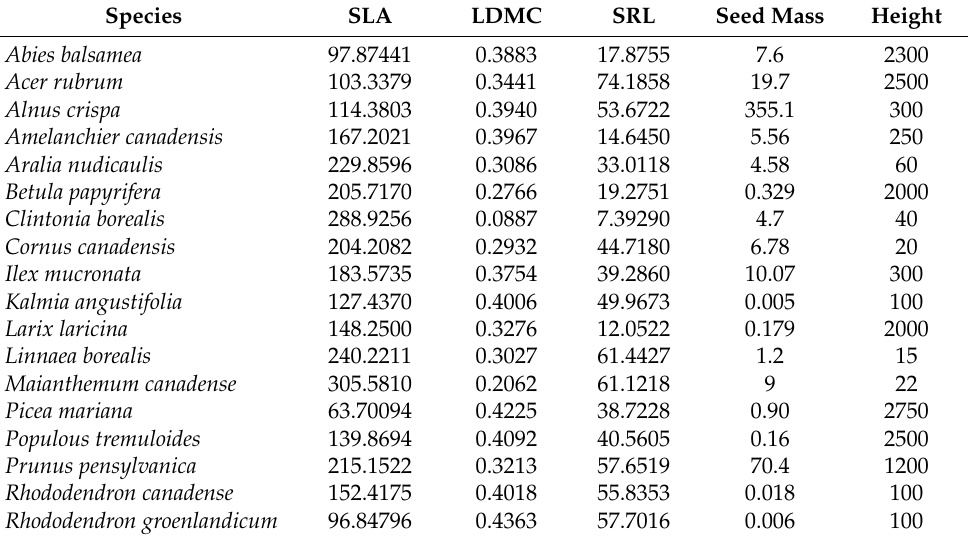
Table A1. Plant trait matrix of the 25 most abundant species and five functional traits, specific leaf area (SLA), leaf dry matter content (LDMC), specific root length (SRL), seed mass, and